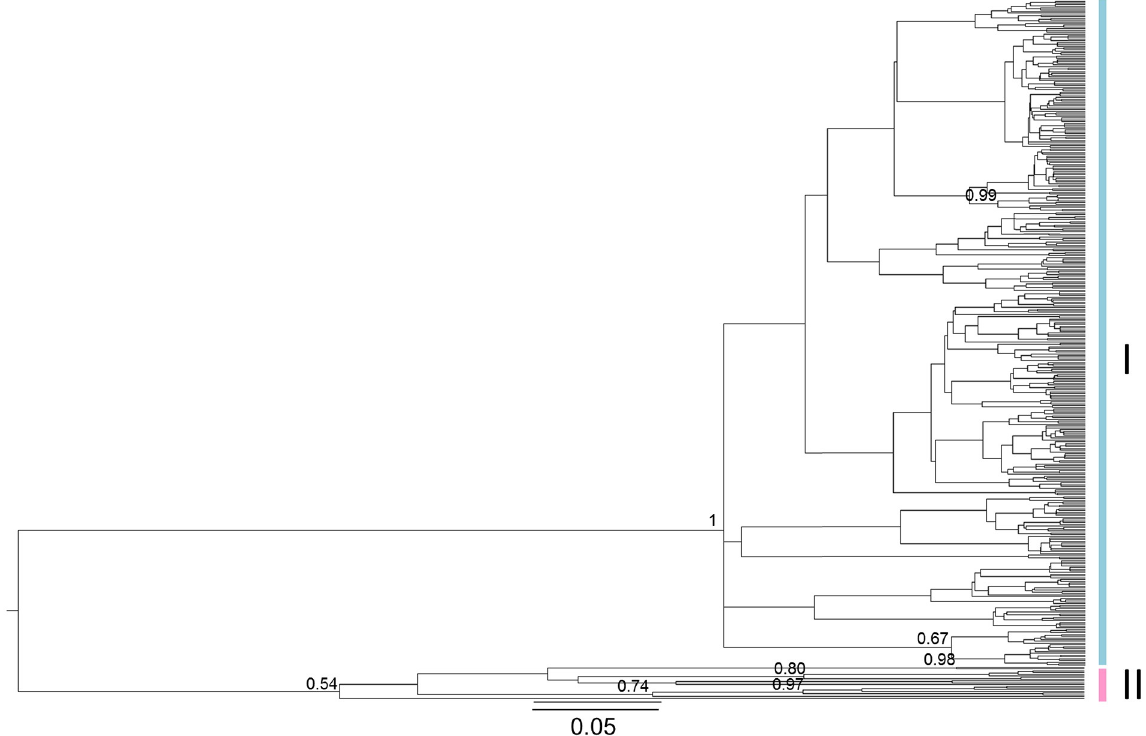
Fig 4. Bayesian maximum clade credibility tree of the mtDNA dataset of Lucanus cervus obtained using BEAST. Bayesian posterior probabilities higher than 0.5 are shown on nodes. Lineage I is indicated in blue and lineage II in pink.